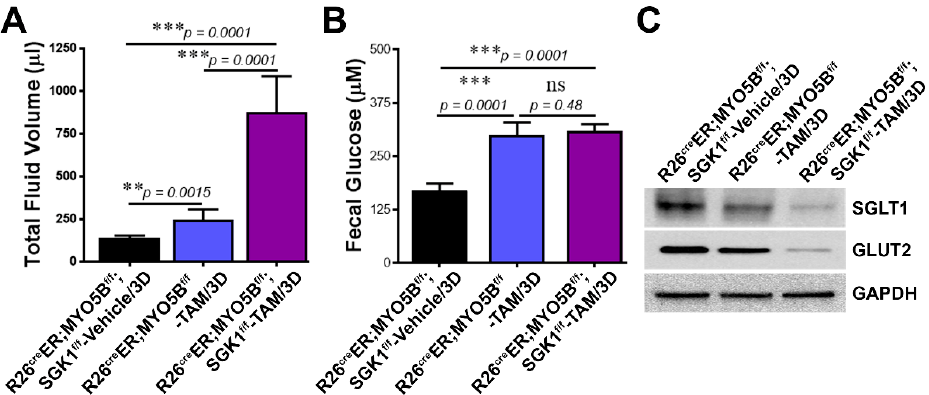
Figure 12. Increased diarrhea in cMYO5B-SGK1 DKO mice is associated with increased carbohydrate loss. Fecal fluid volumes, fecal glucose and mucosal glucose transporter protein expression in tamoxifen ( 2 mg/day/mouse for 3 days)-induced R26 Cre ER;MYO5B f/f (cMYO5B-KO) and R26 Cre ER;MYO5B f/f ;SGK1 f/f (cMYO5B-SGK1-DKO) mice compared to vehicle-treated cMYO5B-SGK1-DKO mice. ( A ) Graphs of volumes of total fecal fluid from mice at day 3 of tamoxifen vs. vehicle induction. Fecal fluid volume was highest in tamoxifen-treated R26 Cre ER;MYO5B f/f ;SGK1 f/f (cMYO5B-SGK1-DKO) mice compared to R26 Cre ER;MYO5B f/f